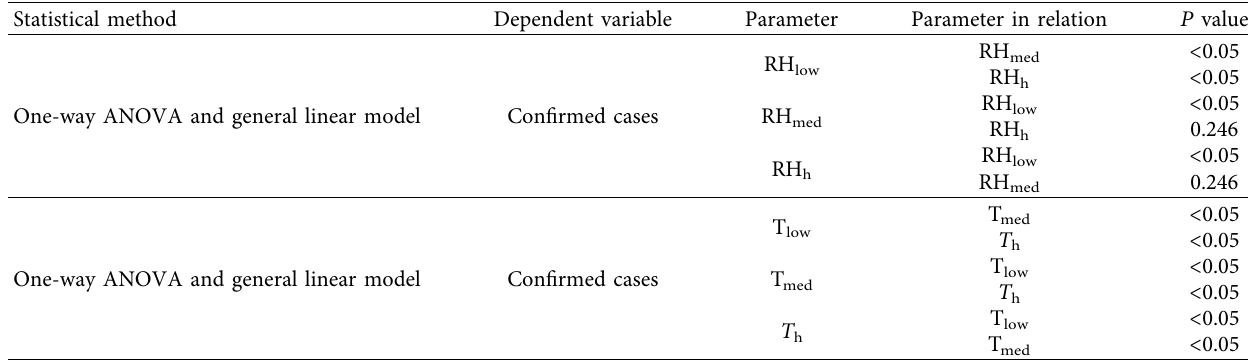
Table 5: One-way ANOVA and general linear model correlations between meteorological factors and COVID-19-infected cases for outdoor